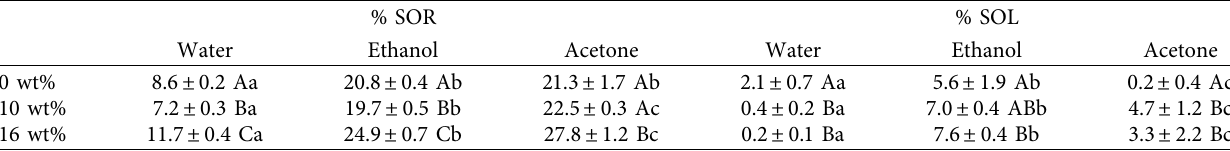
Table 3: Mean ± standard deviation and results of Tukey’s test for sorption (% SOR) and solubility (% SOL) for each experimental group. % SOR % SOL Water Ethanol Acetone